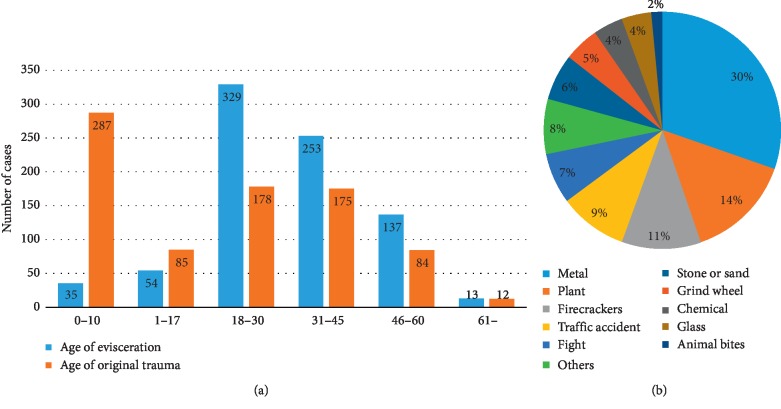
Analysis of the age distribution of the study population and of objects that caused their injury. (a) Most patients underwent evisceration when they were aged between 18 and 30 years, followed by the 31 to 45 years age-group; 89% of the patients who underwent evisceration were adults. However, when considering the age of the patient at the time of the original ocular trauma, most patients were under ten years old (35%), followed by 18–30 and 31–45 years old. (b) The materials of the objects that caused ocular trauma were mostly metal (25%), followed by wood materials (12%). Individual items that caused trauma included fireworks (11%) and grinding wheel (5%).